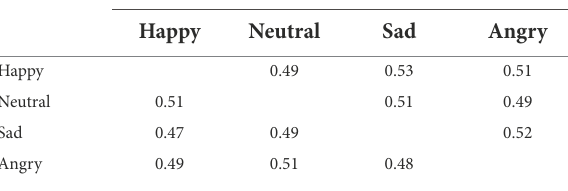
TABLE 5 Average ratio of chosen emotions in 5,000 ms presentation of Experiment